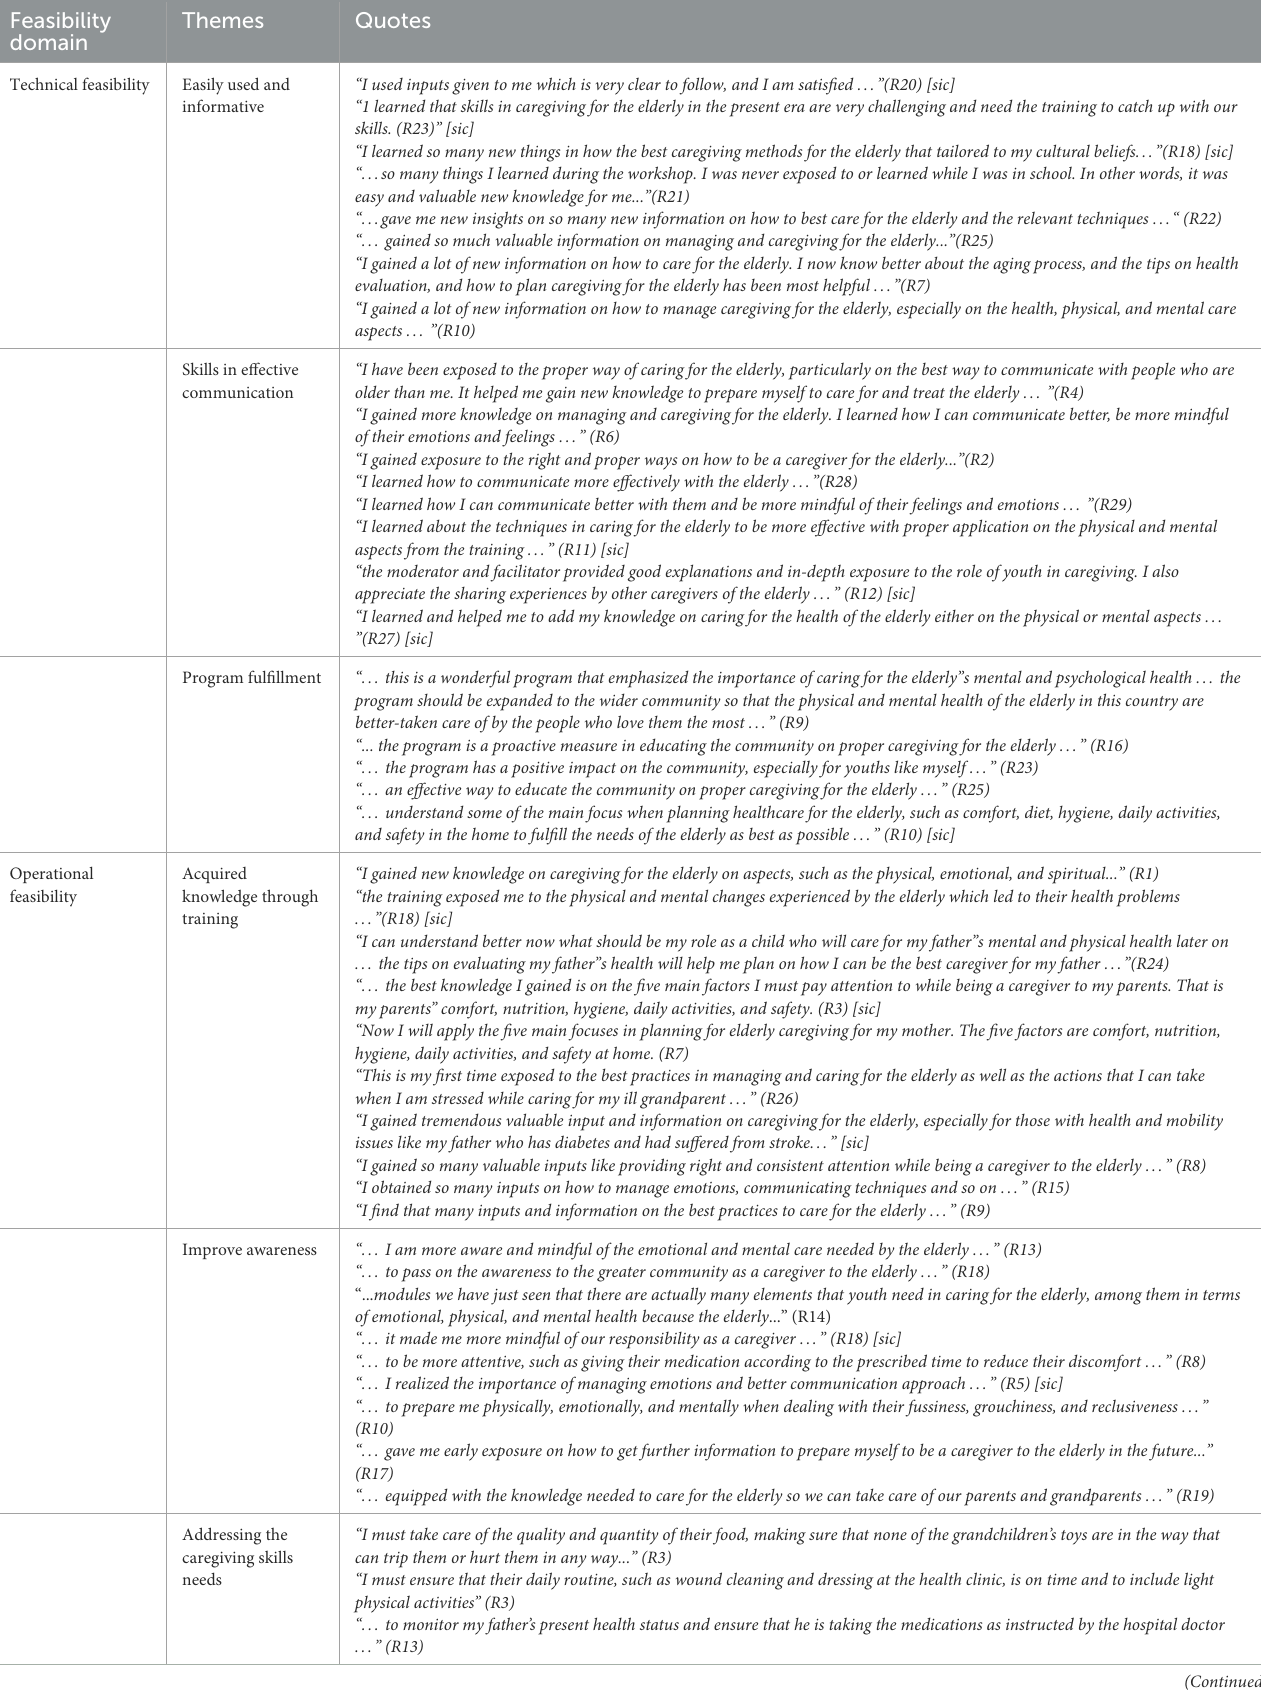
TABLE 4 Summary of the results for theme development in relation to the feasibility